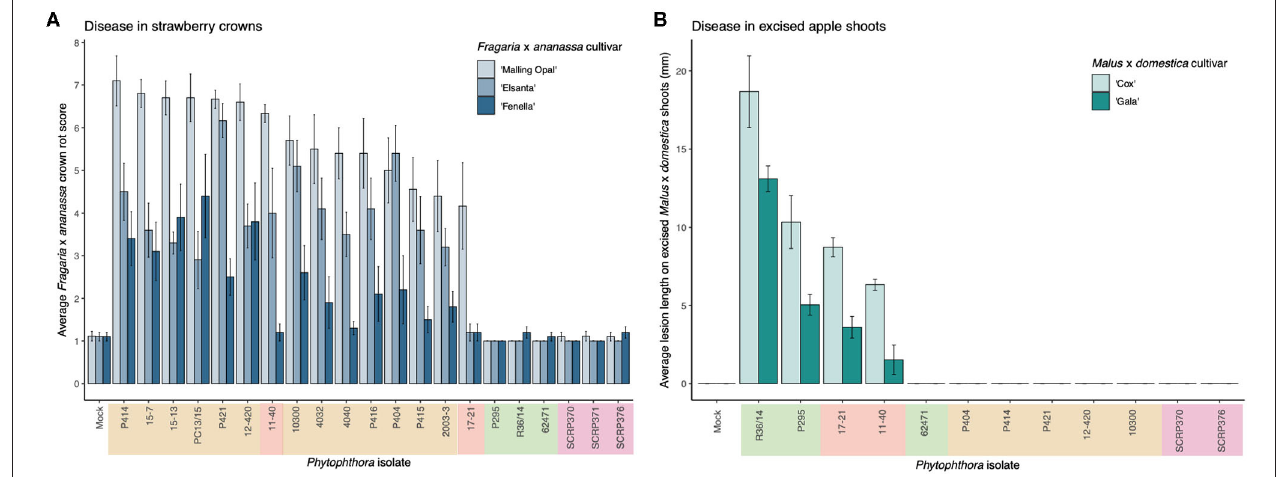
FIGURE 1 | Phytophthora cactorum isolates show specialisation to strawberry crown and apple tissue. (A,B) Virulence of P. cactorum and P. idaei isolates on strawberry crowns and excised apple shoots by artificial inoculation of zoospores and mycelium, respectively. The colour behind the isolate names denotes what plant tissue they were cultured from; beige, strawberry crowns, red, strawberry fruit, green, apple bark and purple, raspberry ( P. idaei ). (A) Virulence of Phytophthora isolates on three Fragaria x ananassa cultivars, ‘Malling Opal,’ ‘Elsanta,’ and ‘Fenella.’ Data are the mean of ten biological replicates ± se. (B) Virulence of Phytophthora isolates on two Malus × domestica cultivars, ‘Cox’ and ‘Gala.’ Data are the mean of six biological replicates ± se.